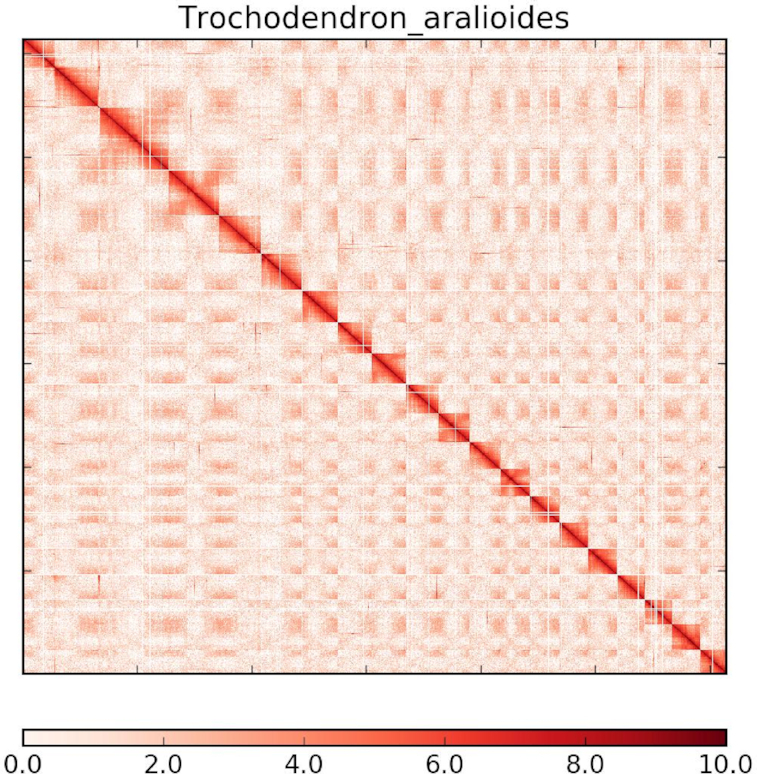
Hi-C interaction heat map for T. aralioides reference genome showing interactions between the 19 chromosomes.